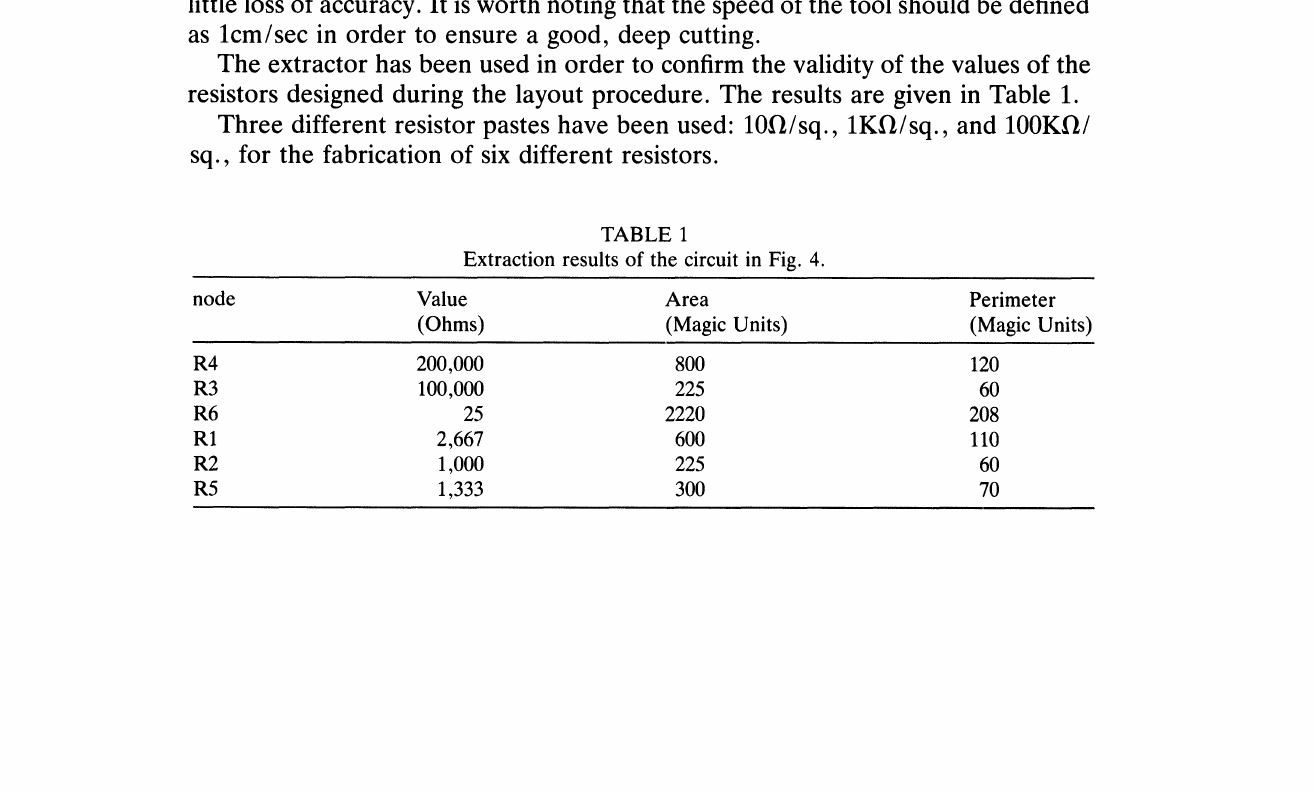
Extraction results of the circuit in Fig.